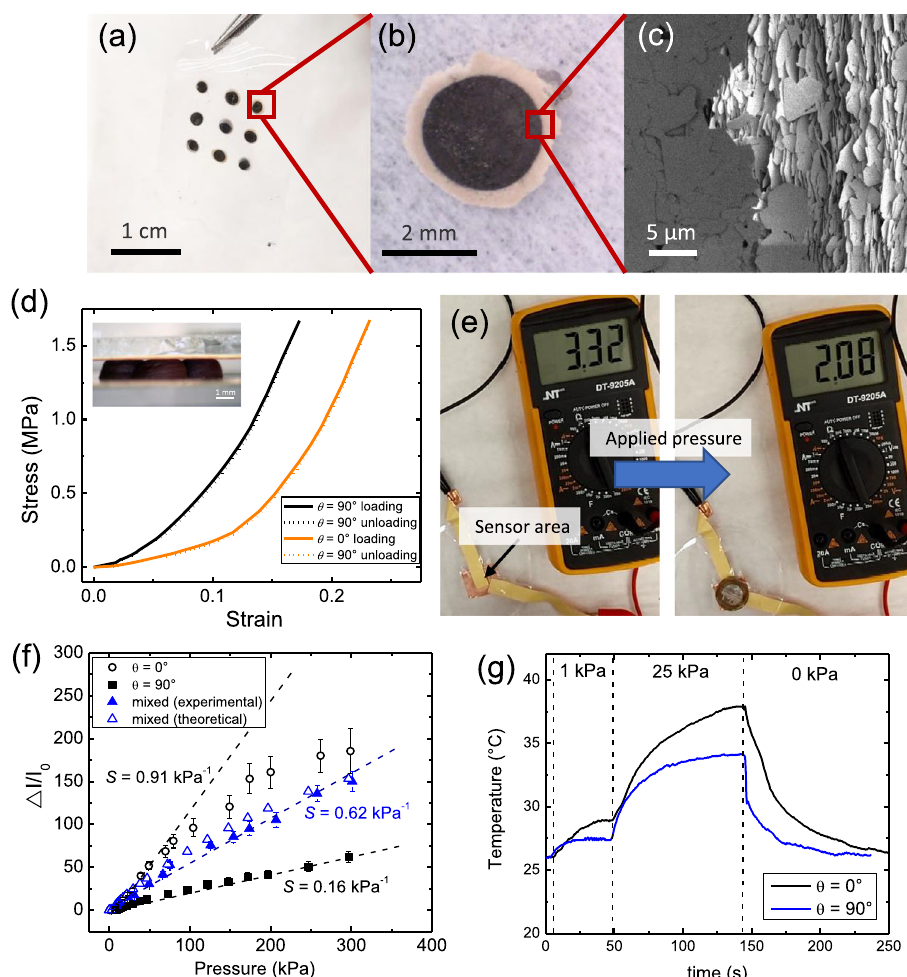
Fig. 6 | Piezoresistive pressure sensor printed using MDOD. a Optical image of MDOD printed piezoresistive pressure sensor consisting of an array of hBN- graphite micropillars embedded in a PDMS fi lm. b Optical micrograph of one individual micropillar in the sensor. c SEM image of the surface of the micropillar showing control of orientation of the graphite (darker region) and hBN (lighter region). d Stress – straincurvesofprintedgraphite-PDMScompositemicropillarsas piezoresistivepressuresensorwithverticalandhorizontalplateletalignment.Inset shows the optical image of the sensor structure whereby the micropillars are sandwiched between copper electrodes. e Photographs showing a reduction